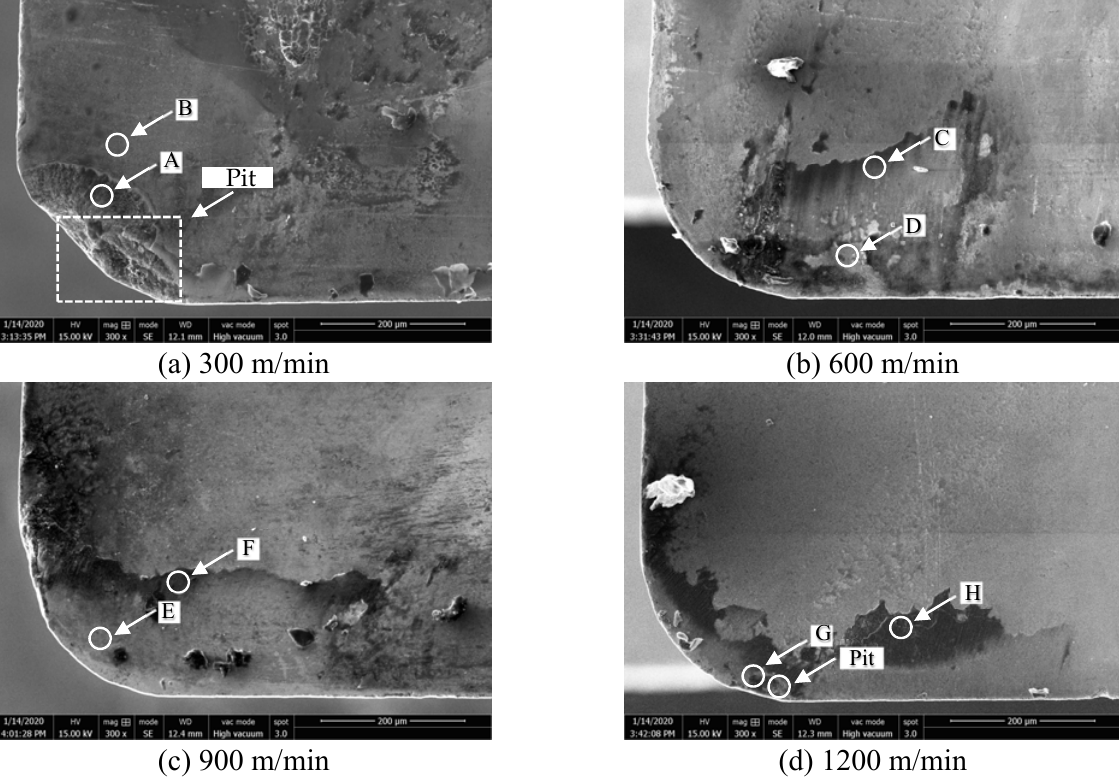
Figure 4. The wear morphology on rake face at different cutting speed (0.05 mm/rev, cutting depth 0.5 mm, cutting width 3 mm). ( a ) 300 m/min; ( b ) 600 m/min; ( c ) 900 m/min; ( d ) 1200 m/min.